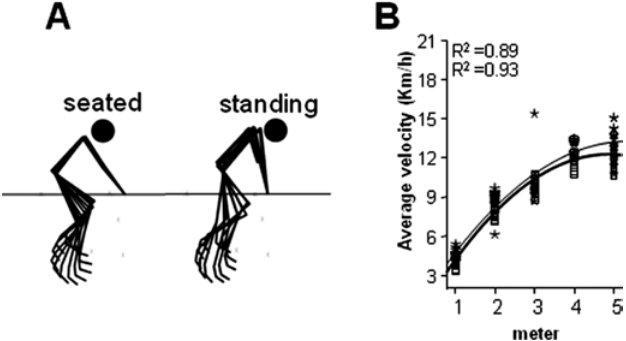
Figure 2. (A) Stick figure of body angles during a standing start in seated and standing positions. (B) Effect of riding position on average speed following a standing start at different distances from the